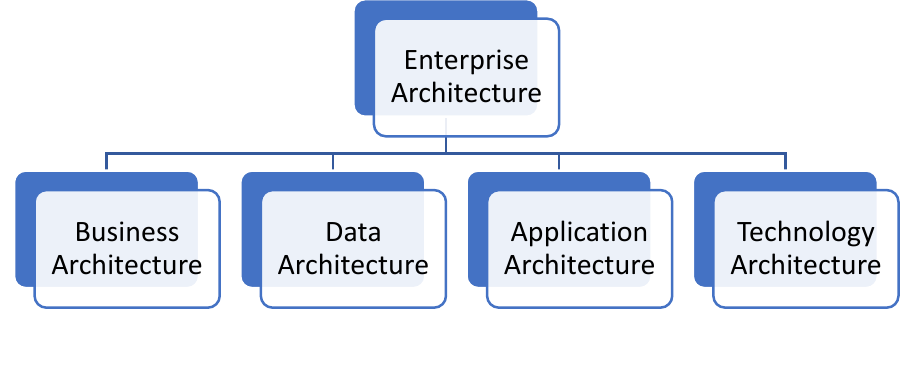
Figure 1. Enterprise Architecture Layers